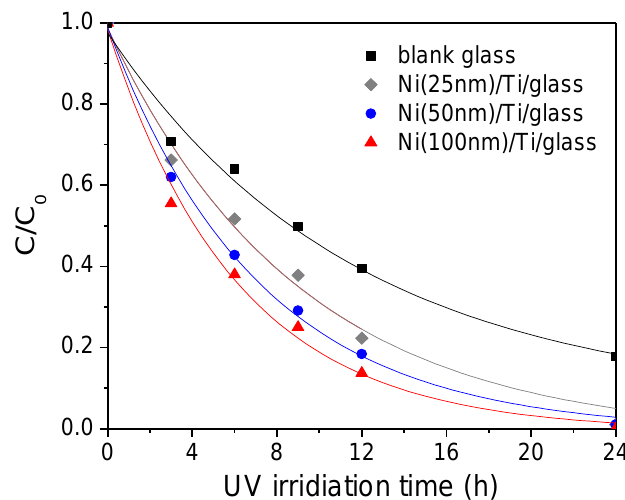
Figure 5. Residual MB concentration (C/C 0 ) versus UV irradiation time for characterizing photocatalysis of 250 °C-deposited TiO 2 films on blank glass and Ni/Ti coated glass with indicated Ni layer thickness.